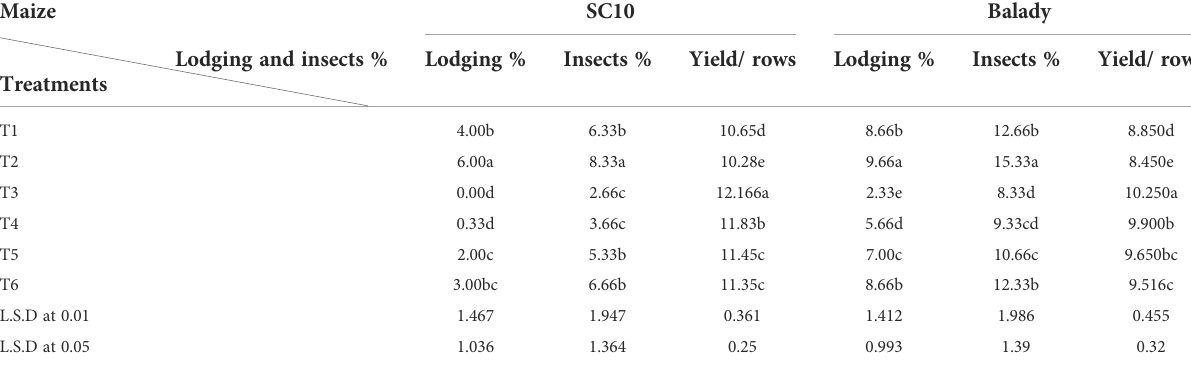
TABLE 11 Percentage of lodging and insect incidence under the tested treatments during 2021 growing seasons. Maize SC10 Balady Lodging and insects % Treatments